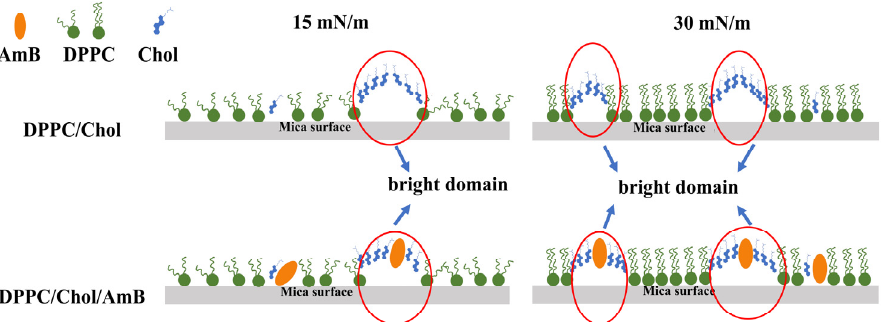
Figure 7. Illustration representing the possible organization of the DPPC/Chol mixed LB film and the DPPC/Chol/AmB mixed LB film.